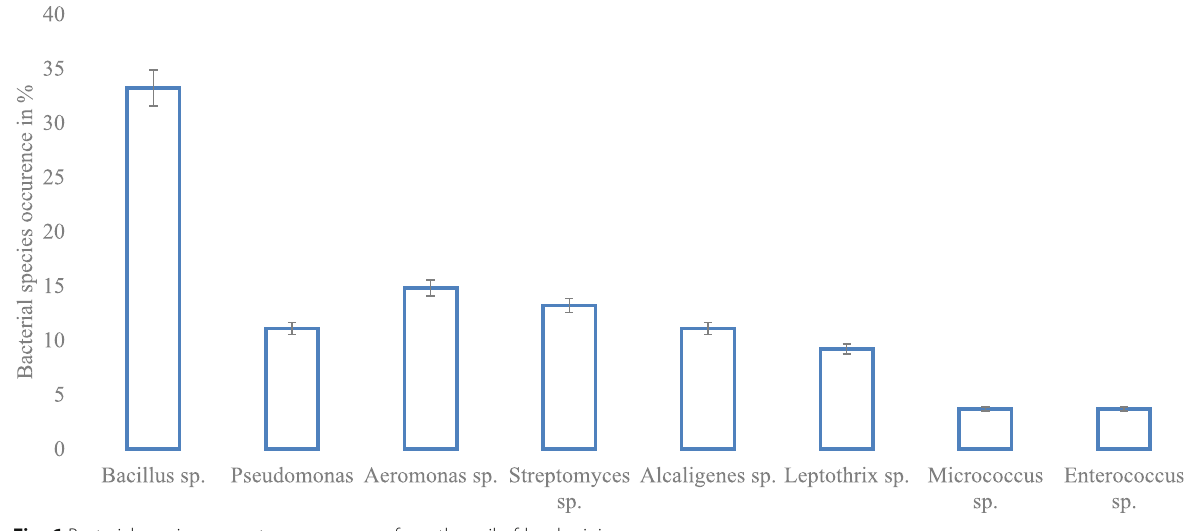
Fig. 6 Bacterial species percentage occurrence from the soil of local mining areas